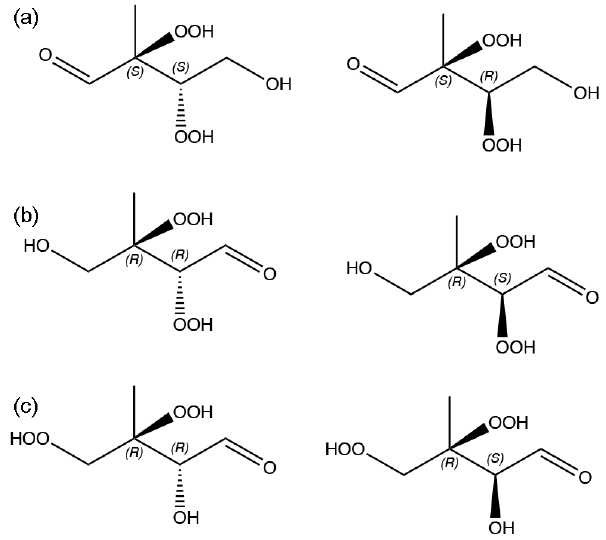
Figure 6. C 5 H 10 O 6 isomers and stereoisomers used in the calcu- lations. (a) isomer 1. (b) isomer 2. (c) isomer 3. The chirality of stereocenters are indicated with S and R letters. Table 3. Saturation vapor pressures and activity coefficients, at 298.15 K, of C 5 H 10 O 6 structural and stereoisomers, computed us- ing COSMOtherm and the BP_TZVPD_FINE_18 parameterization (based on BP/def2-TZVPD//BP/def-TZVP quantum chemical data) with the Systematic conformer sampling